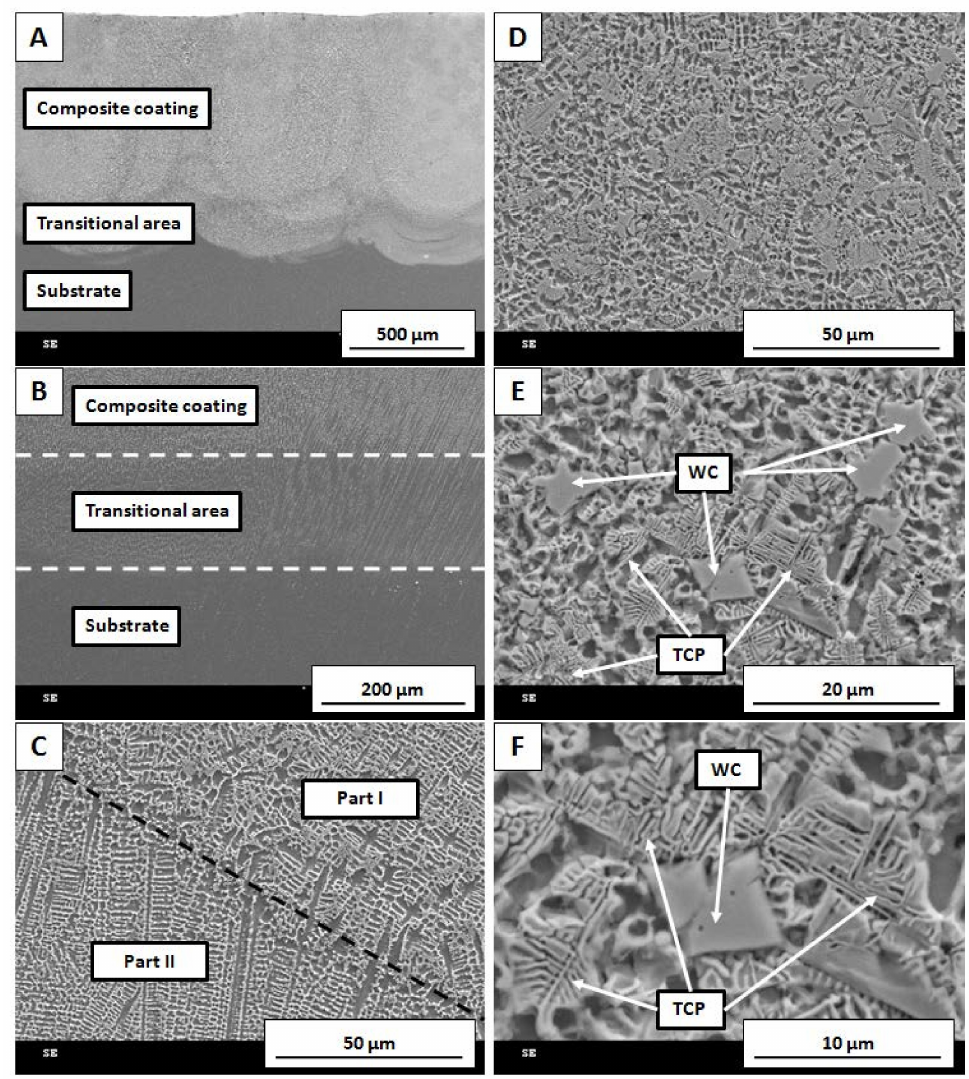
Figure 4. SEM images of different parts of the sample: ( A , B ) cross-section of the coating–substrate boundary, ( C ) area where direction of grain growth was altered, ( D – F ) partially dissolved WC grains with characteristic fishbone-like structure of topologically close-packed (TCP)